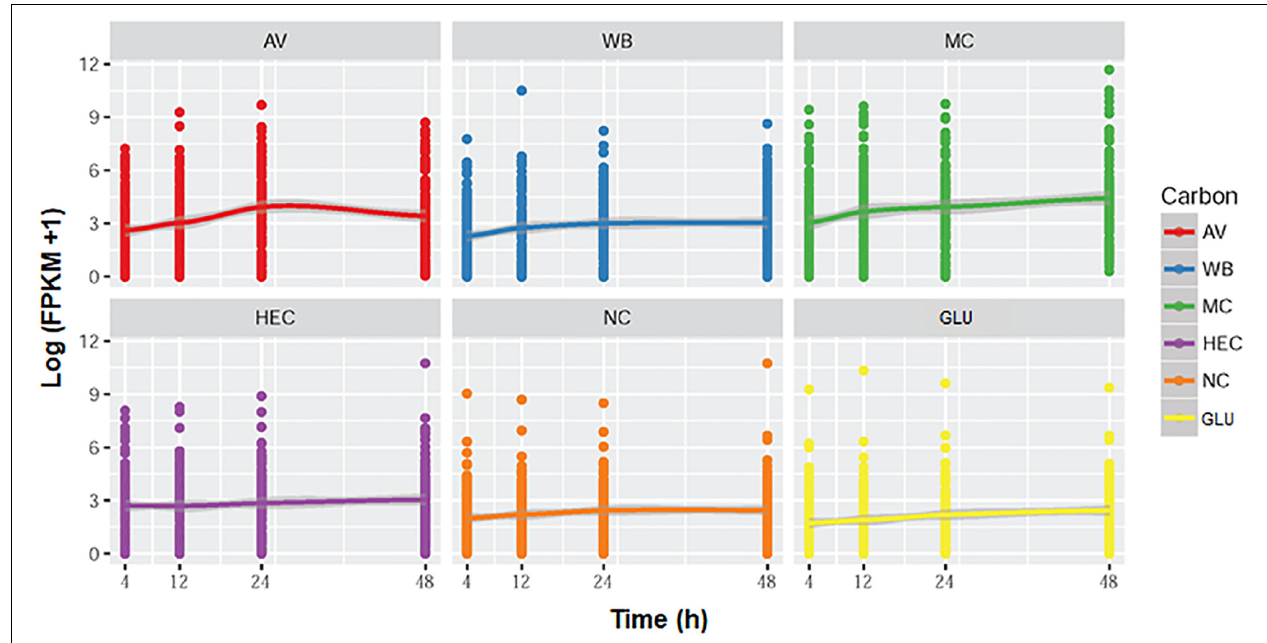
FIGURE 13 | Graphs showing the expression of genes (FPKM) in module MEivory over time. AV, Avicel; WB, wheat bran; MC, methyl cellulose; HEC, 2-hydroxyethyl cellulose; GLU, glucose; NC, no carbon source; FPKM, fragments per kilobase of exon per million mapped